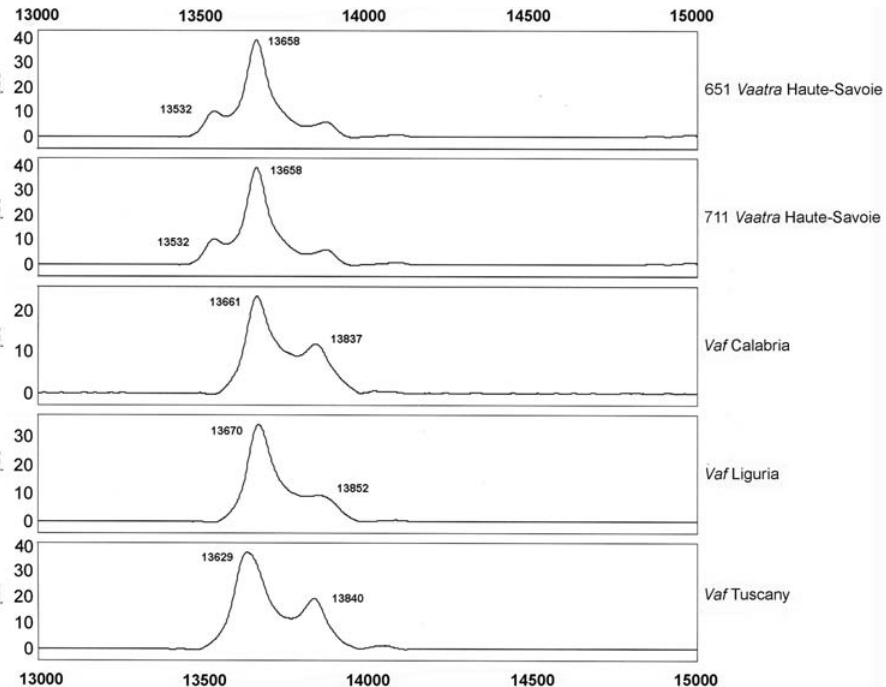
Figure 11. SELDI profiles of venoms from Haute-Savoie (code no. 74) and Italy. Peak molecular weights consistent with those of PLA 2 s are indicated on the spectra.